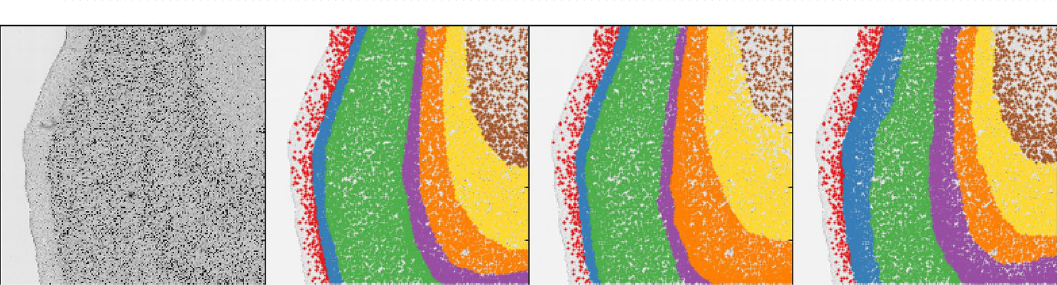
Figure 4. Features based on the local density and convex hull radius are used to obtain tissue features without drawing profiles and sampling perpendicular to the cortex. Left: sparse areas are separated into layer I and white matter. Middle: cortical depth. Right: cortical thickness.